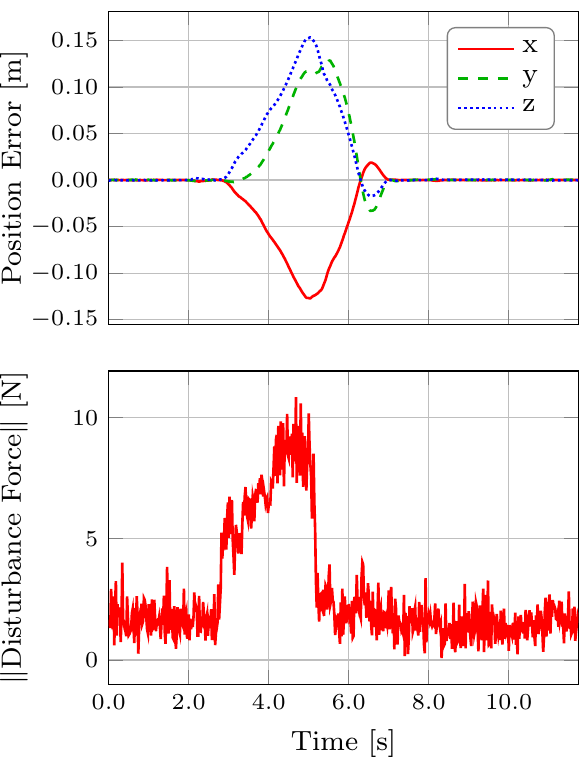
Fig. 18 Cartesian position error and applied disturbance force dur- ing the tracking experiment with payload